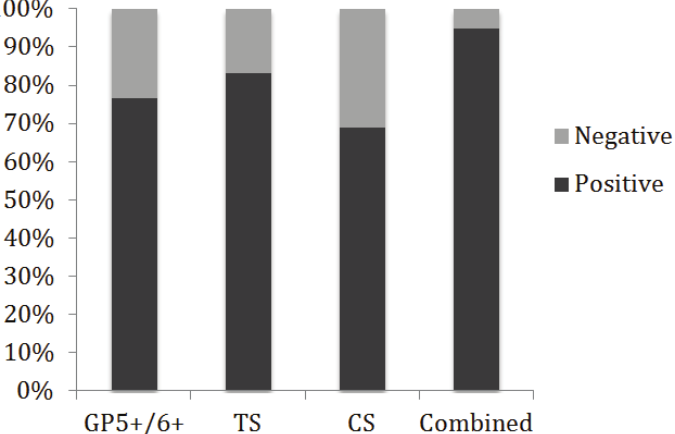
Figure 2. Detection of HPV in cervical lesions using alternative primer sets. Positive HPV detection using the broad range primer set GP5+/GP6+ was determined in 59 out of 77 samples. Sixty-four out of 77 samples were positive with TS primer sets and 53 out of 77 samples were positive with CS primer sets. In total, 73 out of 77 samples were positive with one or more primer sets, indicating an overall HPV prevalence of 94.81% in the cervical lesions